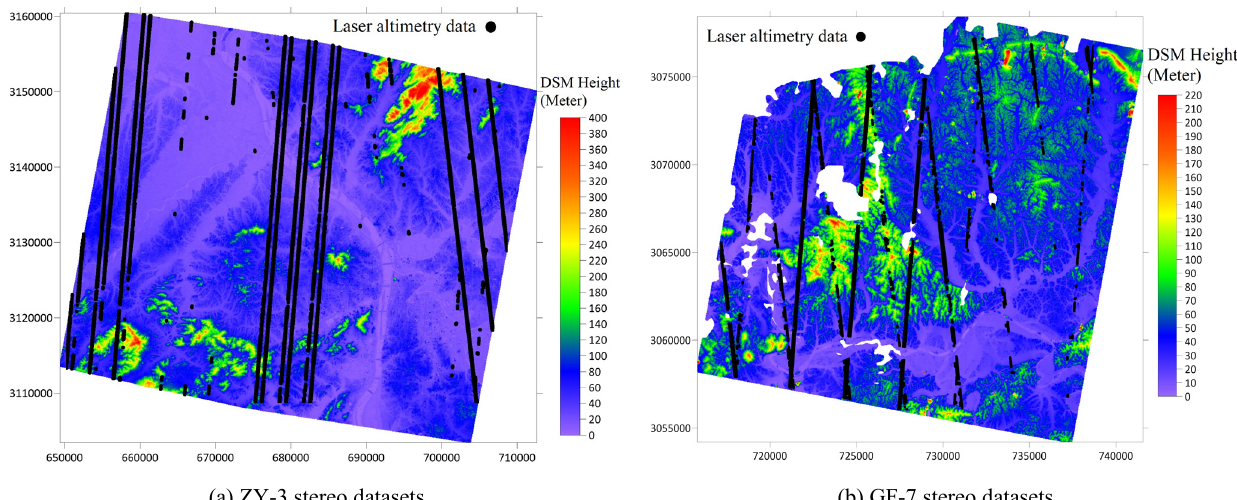
Figure 4. Laser altimetry data is superimposed onto the DSM generated by satellite stereo images. (invalid DSM areas are mainly caused by cloud